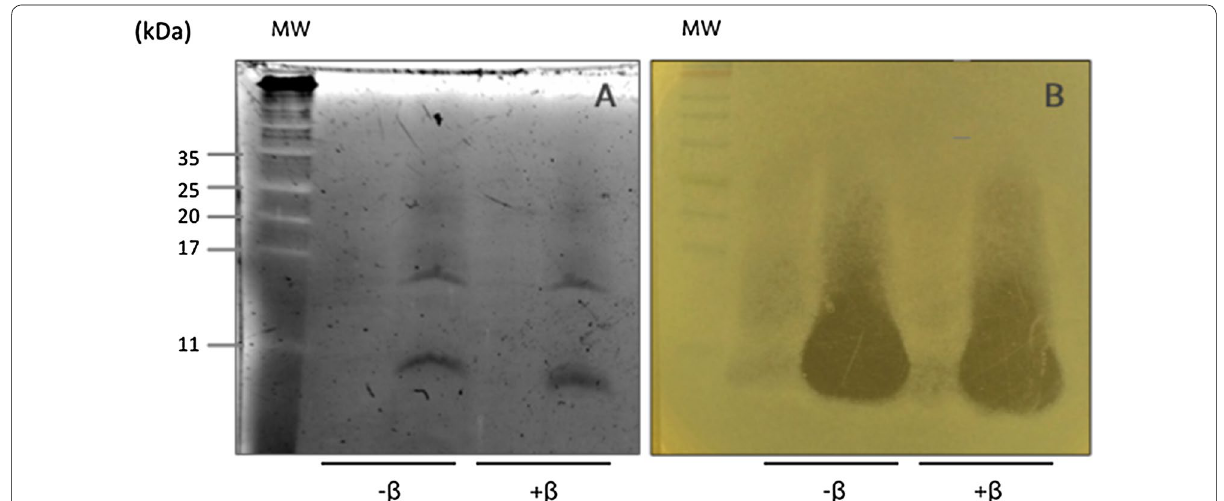
Fig. 3 Direct detection of antimicrobial activity of Lactobacillus acidophilus KS400 bacteriocin ( A ) Tricine‑SDS‑PAGE gel was observed in ChemiDoc ™ MP System (Biorad) using the stain free function for protein gels: (MW) molecular mass protein standards (NZYTECH, Portugal); and presence of β‑mercaptoethanol ( B ) Zone of growth inhibition corresponding to the position of the antimicrobial protein